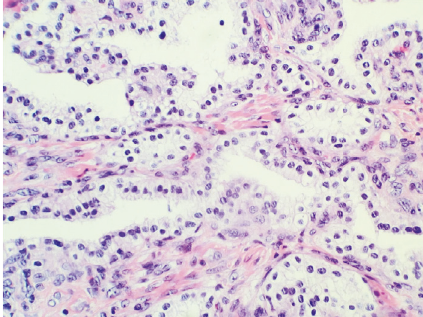
Figure 3: Papillae lined by clear cuboidal to columnar epithelium with bland appearing nuclei.